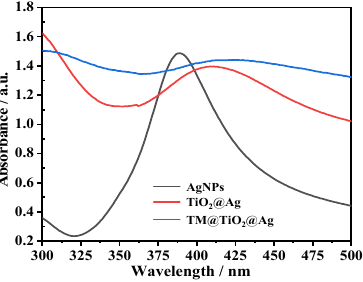
Figure 3. UV-Vis adsorption spectra recorded for the aqueous dispersion of AgNPs, TiO 2 @Ag,